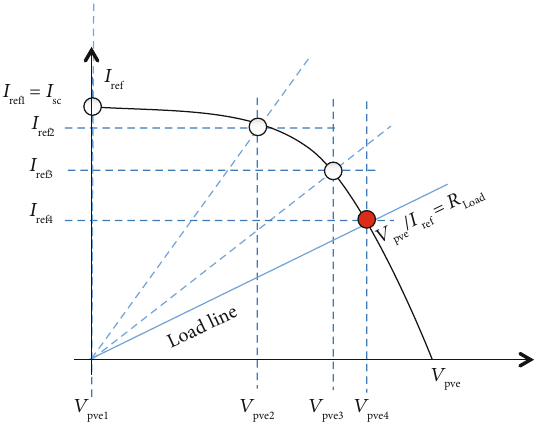
Figure 10: Control strategy